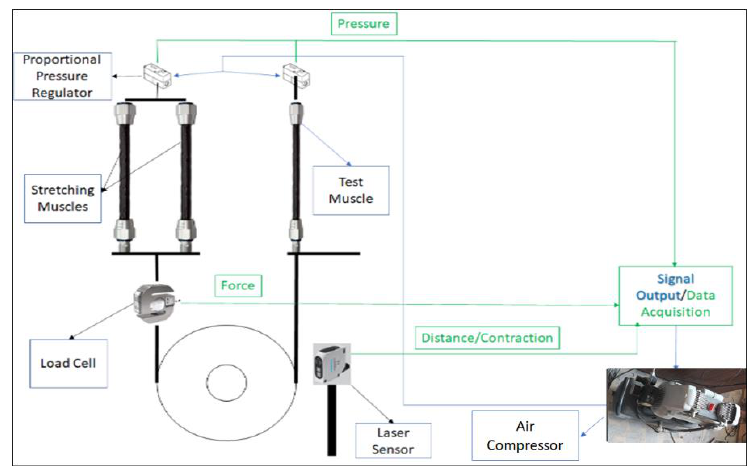
Figure 1. Schematic diagram for the experimental setup.